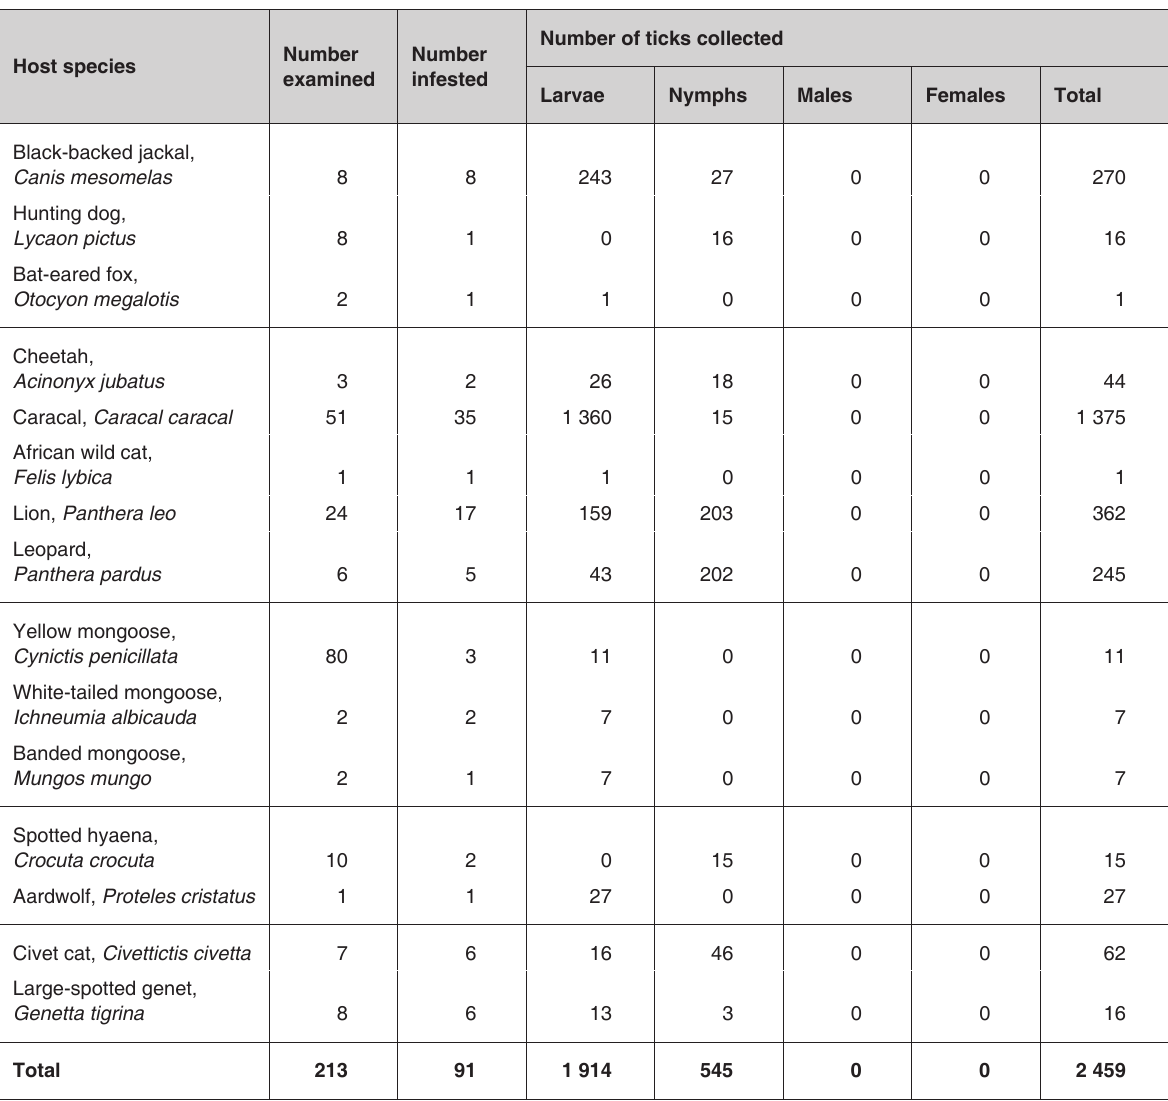
TABLE 4 Amblyomma marmoreum collected from